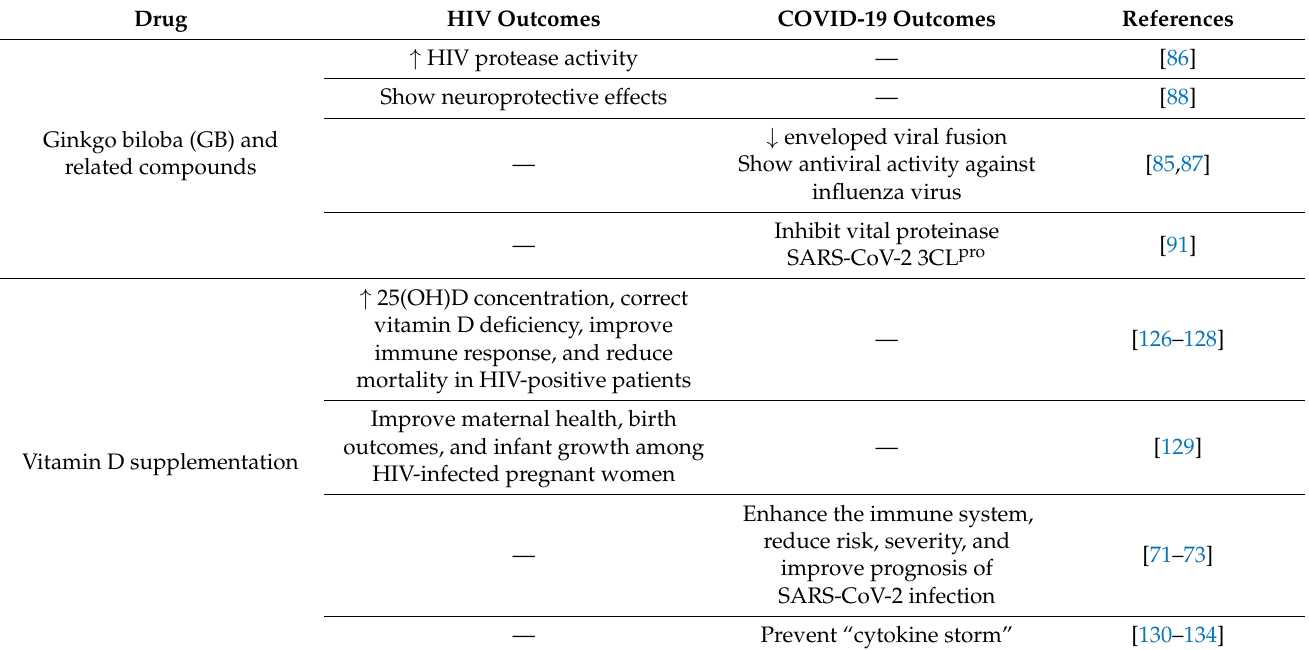
Table 1. Outcome of studies focusing on using nutraceuticals/dietary agents in treating HIV and